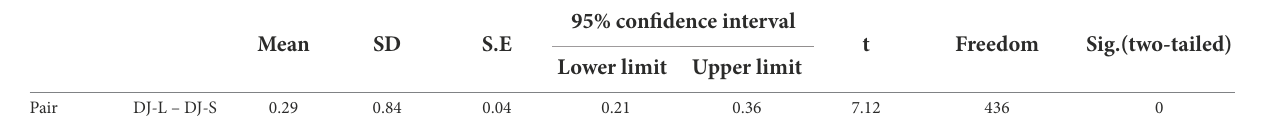
TABLE 9 Paired sample